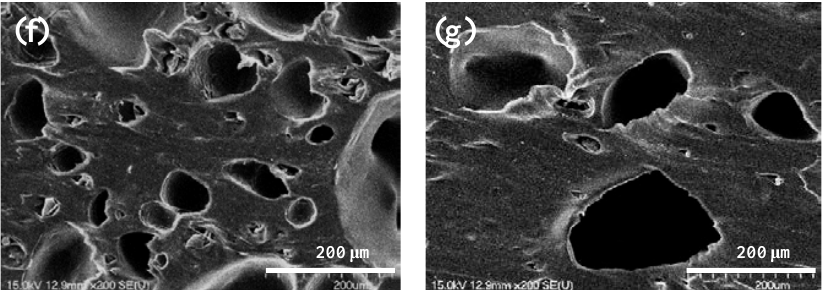
Figure 3. SEM images (X200) of polyester thermoplastic film with various contents of thermally expandable microcapsules: ( a ) 0%, ( b ) 1%, ( c ) 3%, ( d ) 5%, ( e ) 7%, ( f ) 9%, and ( g ) 11%, respectively.